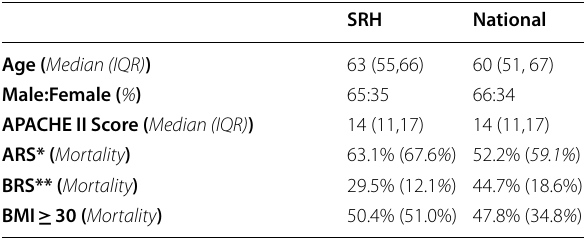
Table 1. Demographics and mortality rates for Sunderland ICCU and national critical care